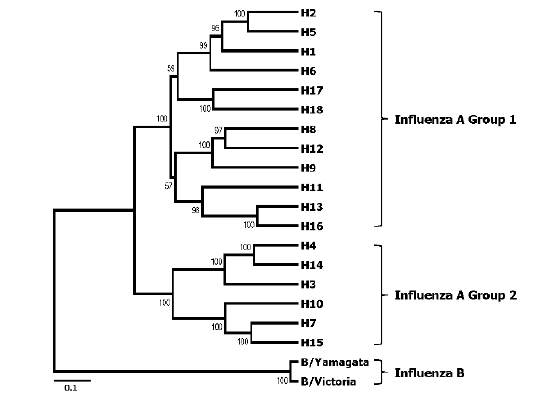
Figure 1. Phylogenetic tree of all subtypes of hemagglutinin (HA) of influenza A and influenza B viruses. The rooted phylogenetic tree was generated based on a full-length amino acid sequence comparison among influenza A and B viruses. The representative sequence of each HA subtype, including recently added H18, was obtained from the Influenza Virus Resource of NCBI for multiple alignments, and the phylogenetic tree was generated by the ClustalW algorithm in Mega version 6.0 using UPGMA method. The scale bar represents a 10% amino acid change, and the bootstrap values are given at each